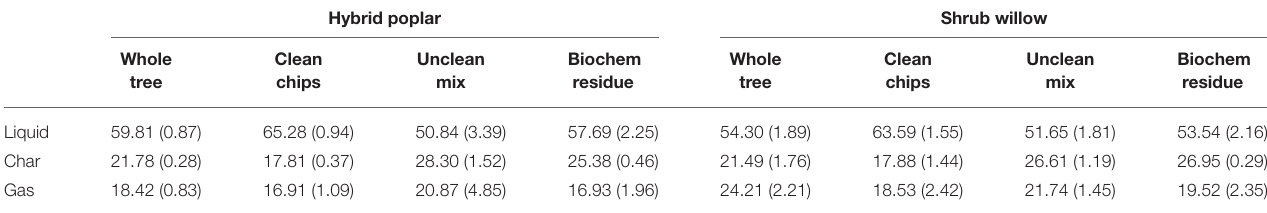
TABLE 4 | Liquid, char, and gas yields from various fractions of hybrid poplar and shrub willow.